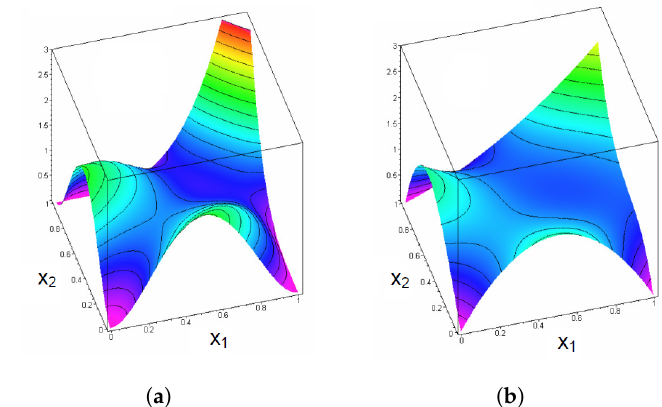
. ( b ) Copula density x 1 , x 2 p q